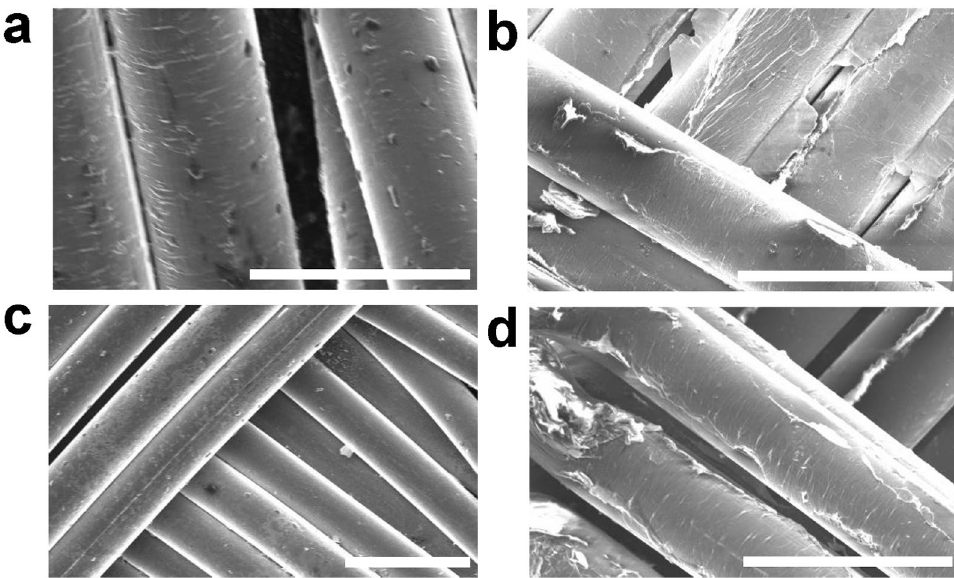
Figure 1. Investigation of fabric morphology. SEM images showing the coated fabric without washing ( a , c ), and after 100 cycles of ISO-standard wash ( b , d ) for the RGO and RGO/MoS 2 coated fabric, respectively. The scalebars are ( a ) 30 µm, ( b ) 40 µm, ( c ) 50 µm and ( d ) 40 µm